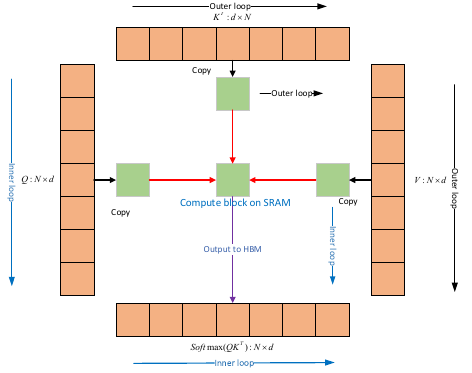
Figure 1. Structure of encoder and MA module.